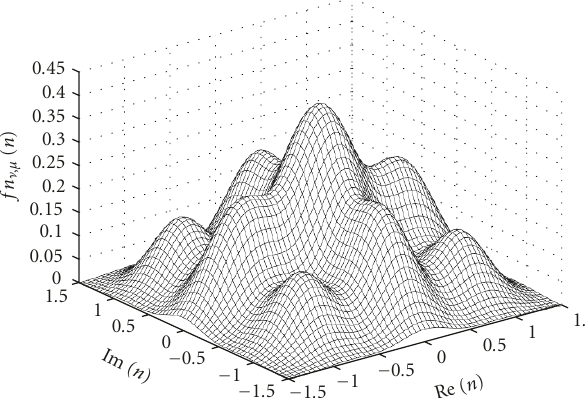
Figure 6: Hybrid pdf approximation of ISI, MAI, and noise for ( E b / N 0 ) = 10dB with t (cid:2) = 2. 10log 10